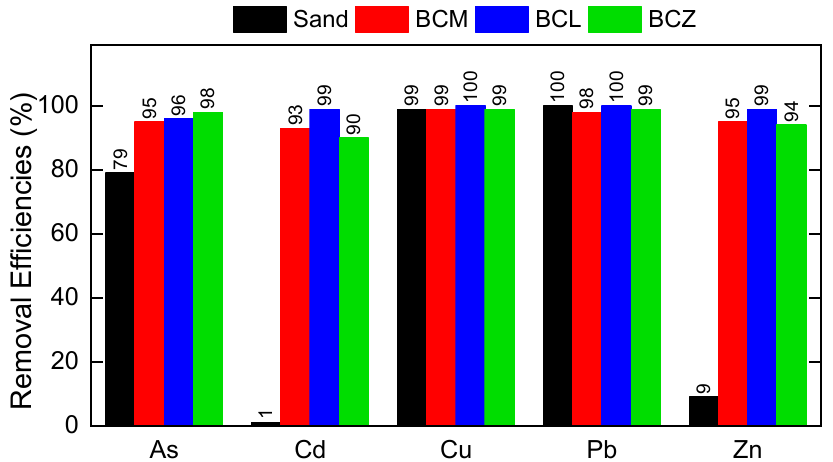
Figure 5. Concentration changes of ( a ) As; ( b ) Cd; ( c ) Cu; ( d ) Pb; and ( e ) Zn in the effluents from different column configurations (Sand, BCM, BCL, and BCZ) with respect to time.